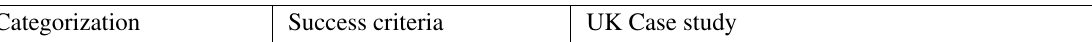
Table 4. UK case study evaluation upon urban design success criteria. Authors based on (CABE, 2003; Homes and Communities Agency; English Partnerships, 2007; UN-Habitat, 2016; UDG, 2012; Carmona M. , 2013; Department